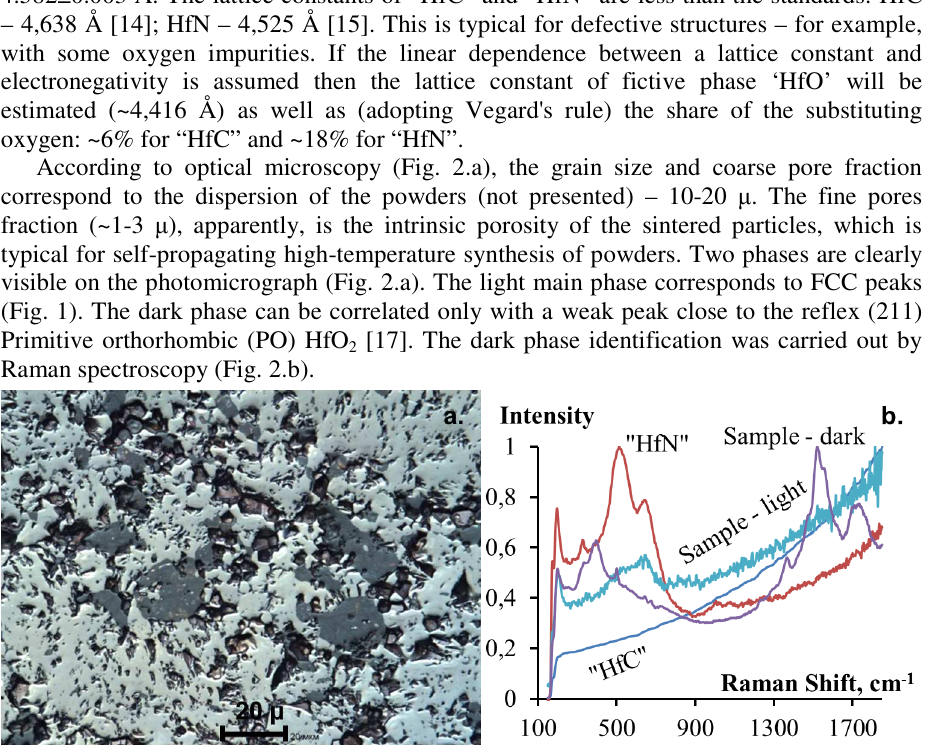
Fig 2. a. The Sample test surface microphoto. b. The Raman spectra for powders and Sample phases. The porosity preservation indicates the sintering without significant softening which is fully corresponds to a low sintering temperature (~2100 C) in comparison with the melting points of HfC (~3890 C) and HfN (~3380 C). The formation of a new solid solution phase occurred during the mutual diffusion of C and N. It required lower temperatures in comparison with the SPS production of Ta HfC [8, 9] ( ≥ 2350 C), which may be explained 4 5 by the facilitated diffusion of C and N due to their smaller masses and sizes (v.s. Ta and Hf). "HfC" and the main (light) phase do not have a pronounced spectrum in the investigated range of Raman shifts. The "HfN" lines correspond to HfN with a defective structure